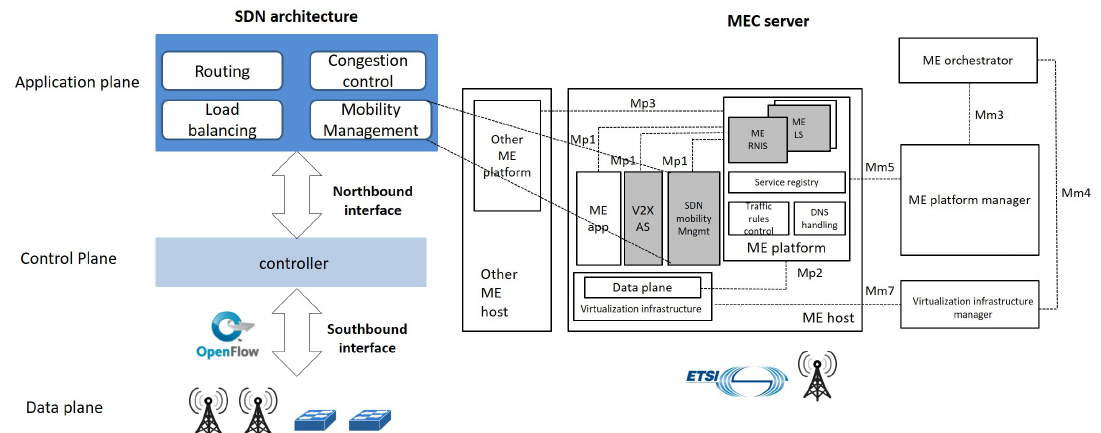
Figure 3. SDN architecture with main network applications ( left ) and MEC server deployment ( right